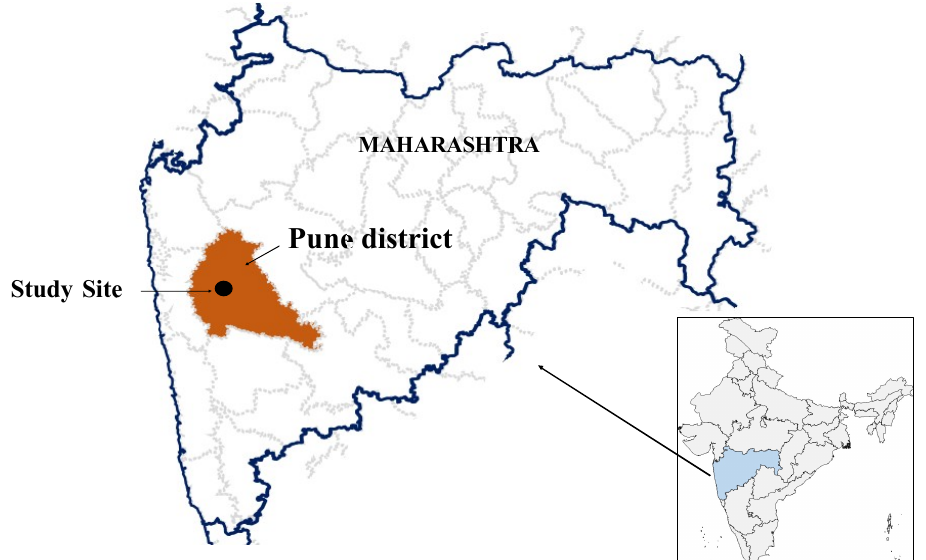
Figure 1. Location of Study Site.